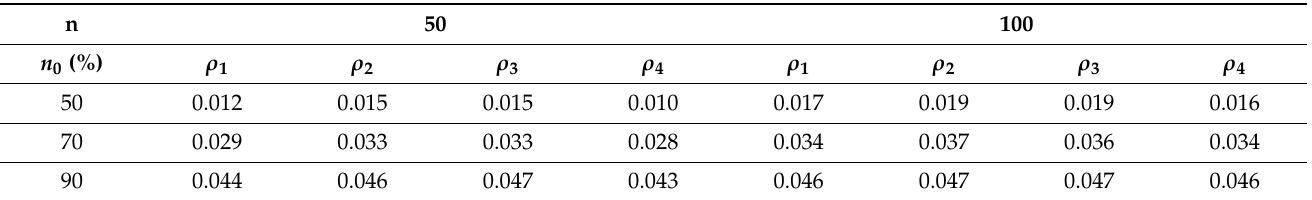
Table 3. Type I error estimation results for the case of dependent curves and θ = 0.78.